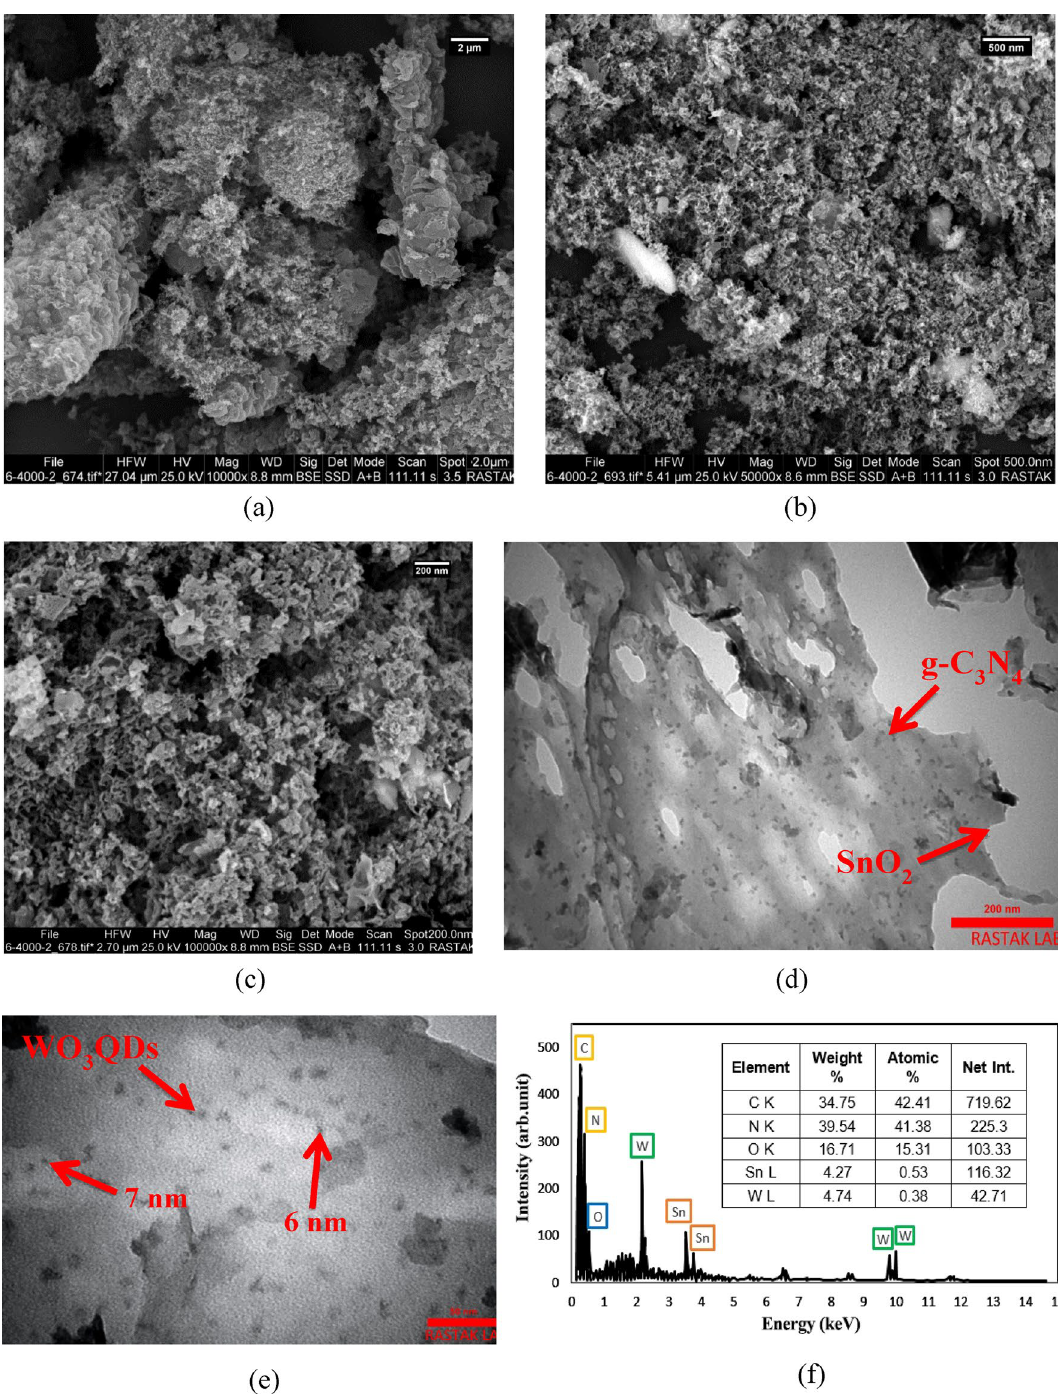
Figure 2. SEM images of ( a ) CN, ( b ) CNS, ( c ) CNSWQ, and ( d , e ) TEM images of CNSWQ, and ( f ) EDX analysis of